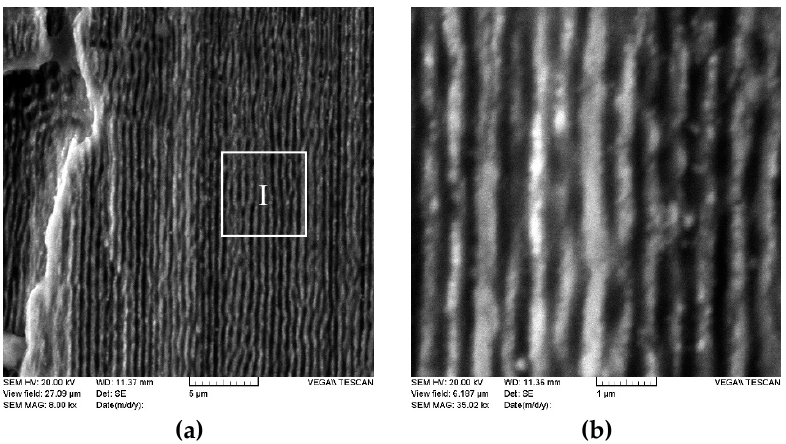
Figure 2. SEM images: ( a ) surface nano laser-induced periodic surface structures (LIPSS) formed using a femtosecond laser irradiation on a grinded steel surface; ( b ) enlargement of the marked area I.